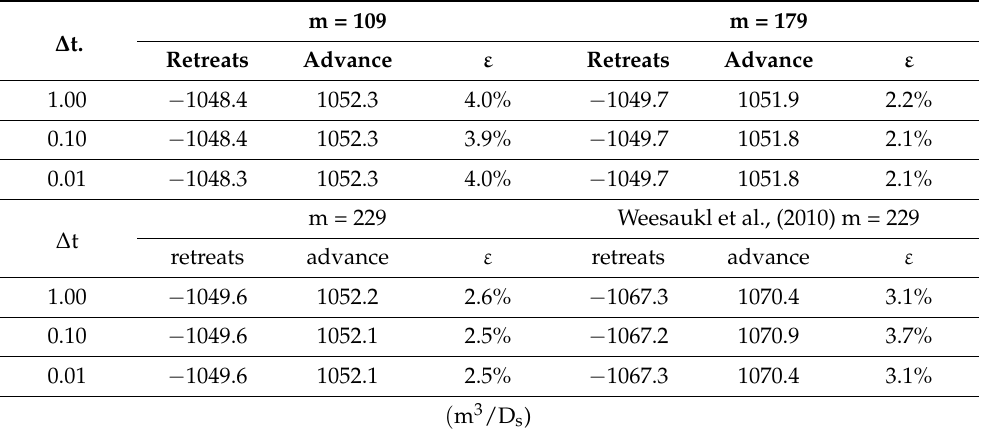
Table 2. Numerical results of area of shoreline retreats and advance by comparing the initial shoreline with steady